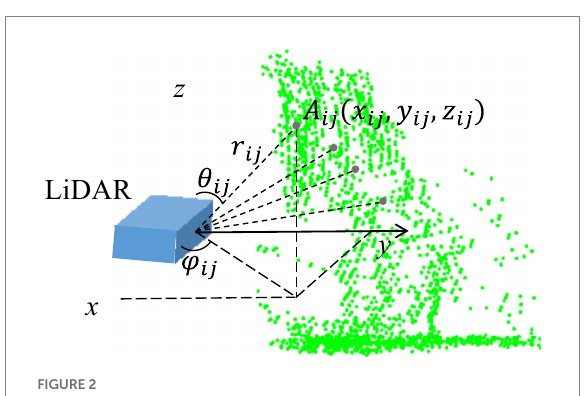
FIGURE 2 Schematic of the drift cloud scanned in the Cartesian coordinate